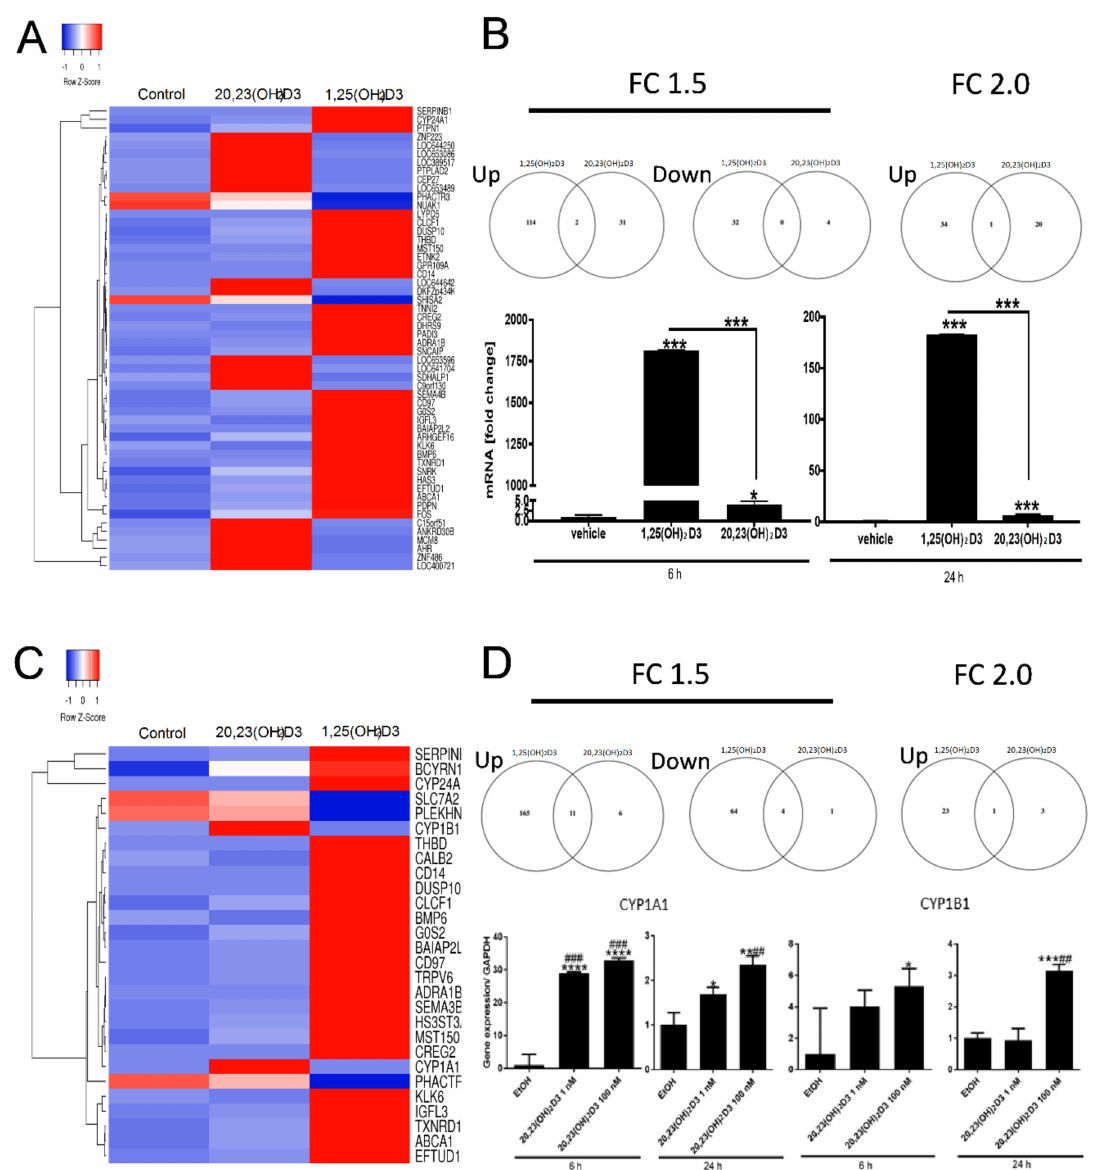
Figure 3. Changes in gene expression in human epidermal keratinocytes treated with 1,25(OH) 2 D3 or 20,23(OH) 2 D3 for 6 h. ( A ) Heat map of the gene expression pattern for experiment #1 with corresponding Venn diagrams for FC ≥ 2 and 1.5. ( B ) Effect of 10 − 7 M of 1,25(OH) 2 D3 or 20,23(OH) 2 D3 on CYP24A1 expression in keratinocytes after 6 and 24 h treatment. ( C ) Heat map of the gene expression pattern for experiment #2 with corresponding Venn diagrams for FC-2 and 1.5. ( D ) Effect of 10 − 9 and 10 − 7 M of 20,23(OH) 2 D3 on CYP1A1 and CYP1B1 expression in keratinocytes after 6 or 24 h treatment. Data represent means ± SD ( n = 3) where * p < 0.05, ** p < 0.01, *** p < 0.001 and **** p < 0.0001 at student t -test; ## p < 0.01 and ### p < 0.001 at one-way ANOVA